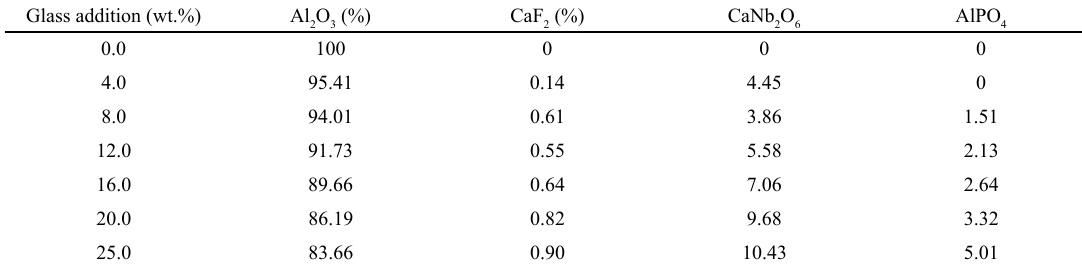
Table 2. Percentage of crystalline structures, according to the glass addition. Glass addition